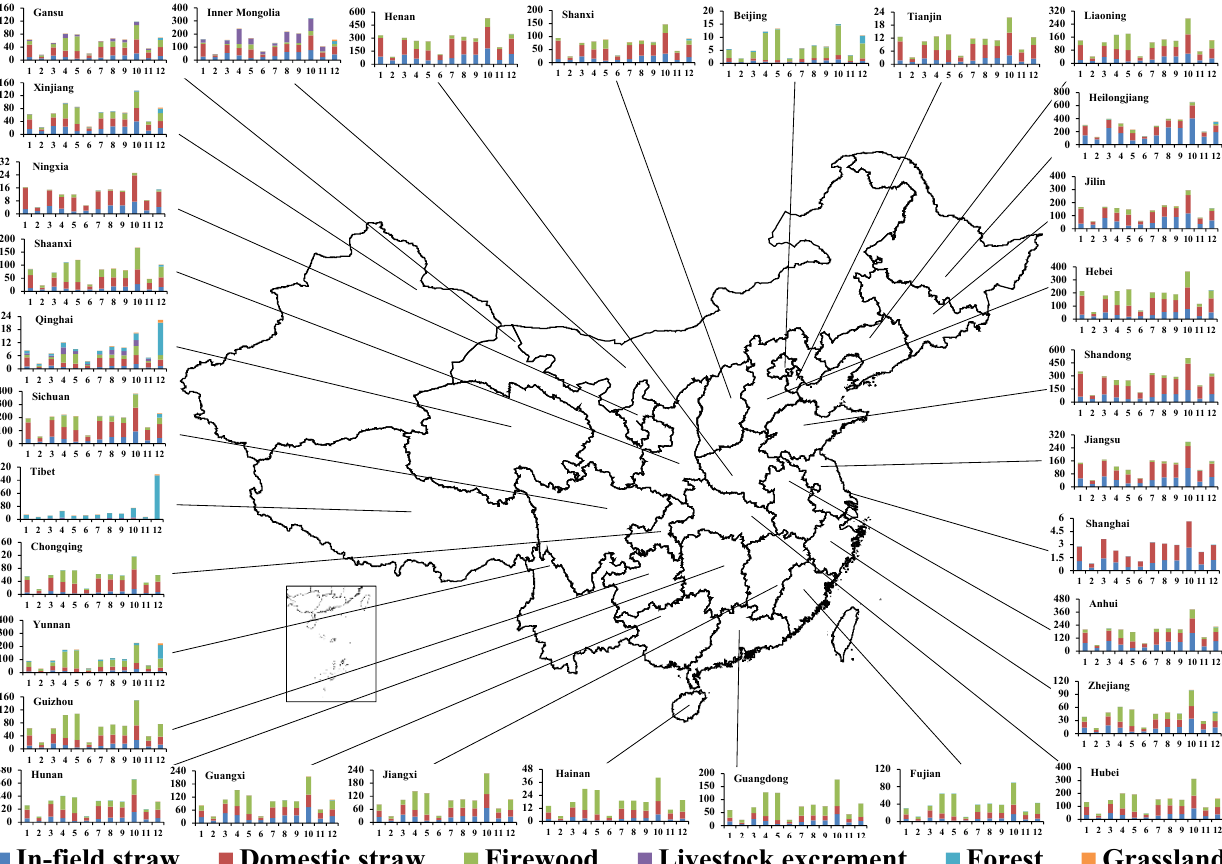
Figure 4. Contributions of different biomass sources to the emission in each province (Gg). Note that numbers 1–12 represent the pollutants of SO 2 × 10, NO x , NMVOC, NH 3 × 10, EC × 10, OC, CO / 10, PM 10 , PM 2 . 5 , CO 2 / 100, CH 4 , and Hg × 1000000,